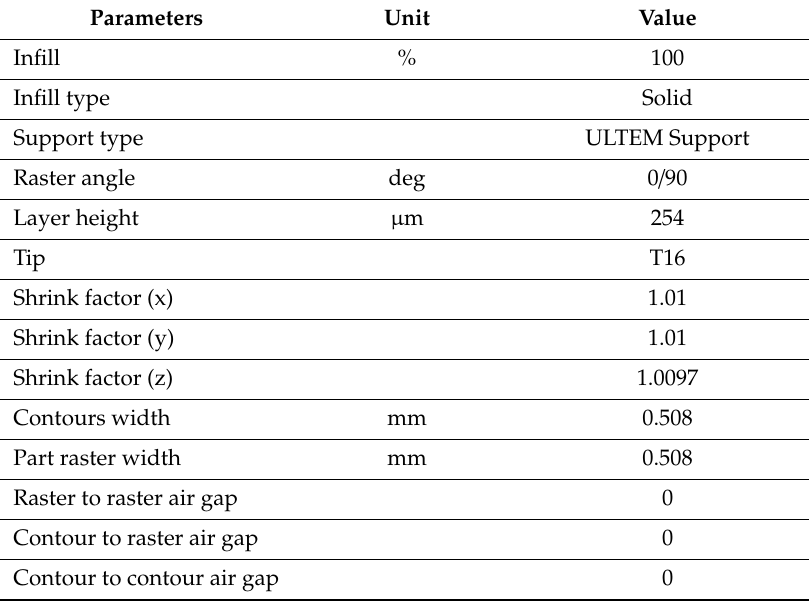
Table 2. Printing conditions for the preparation of the specimens.